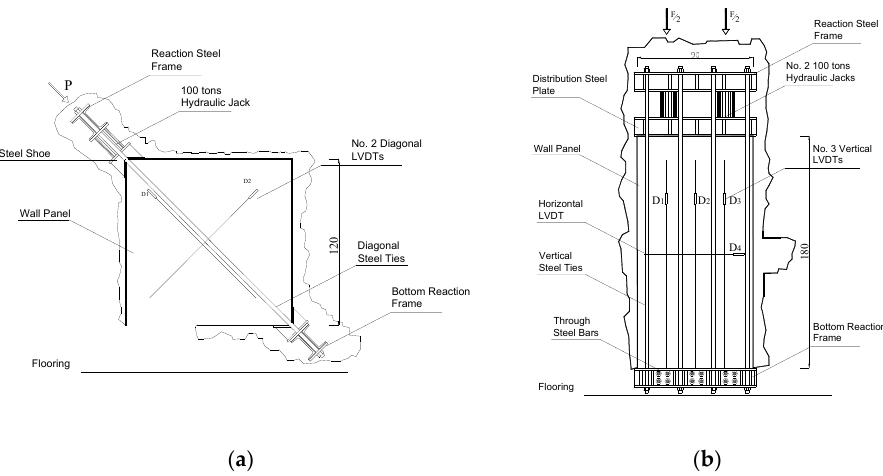
Figure 6. Instrumentation and test layout: ( a ) Diagonal tension test; ( b ) Compression test [dimensions in cm].